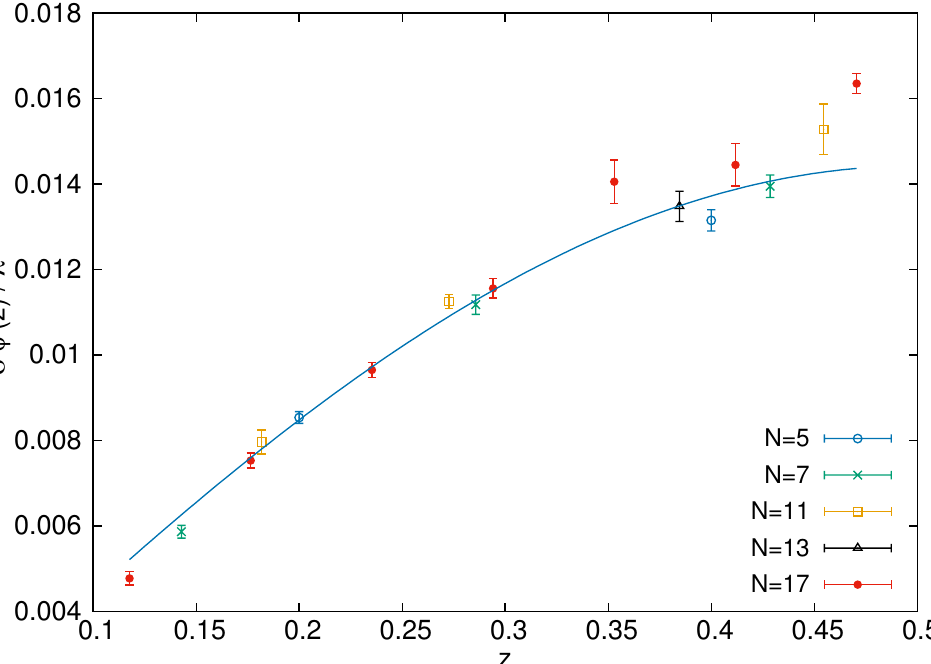
Figure 1. We display the z -dependence of the function (cid:27) 0 (cid:30) ( z ) =(cid:21) 2 appearing in eq. (3.4), extracted from (cid:12)tting the x -dependence of the energy of electric (cid:13)ux ~e = ( zN; 0) for minimum momentum j ~p j = p 0 and various values of N and the magnetic (cid:13)ux k . The continuous line is the function p ( (cid:27) 0 =(cid:21) 2 ) sin( (cid:25)z ) =(cid:25) , for the best (cid:12)t value (cid:27) 0 =(cid:21) = 0 :